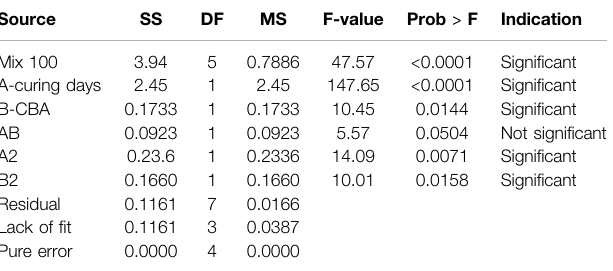
TABLE 10 | ANOVA for the response surface quadratic model.